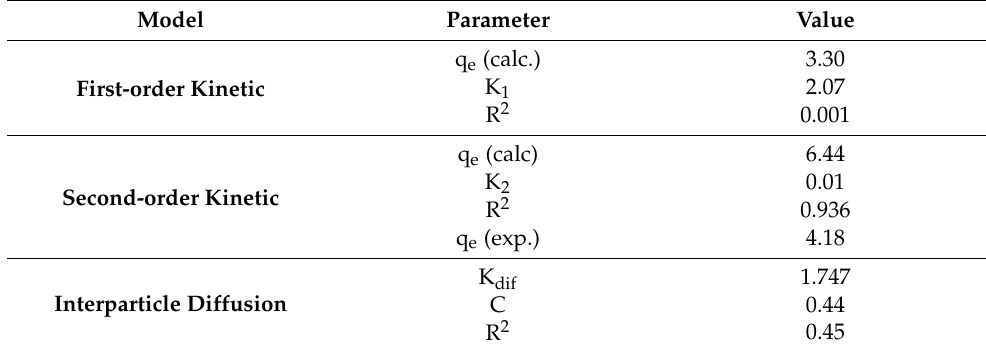
Table 5. The comparison of the first order, second-order, and intraparticle diffusion for adsorption rate